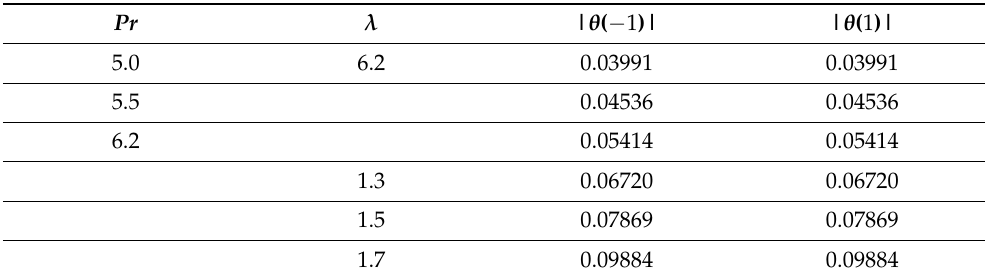
Table 5. Numerical effect of heat transfer on the Prandtl number and dimensionless exother- mic/endothermic parameter.